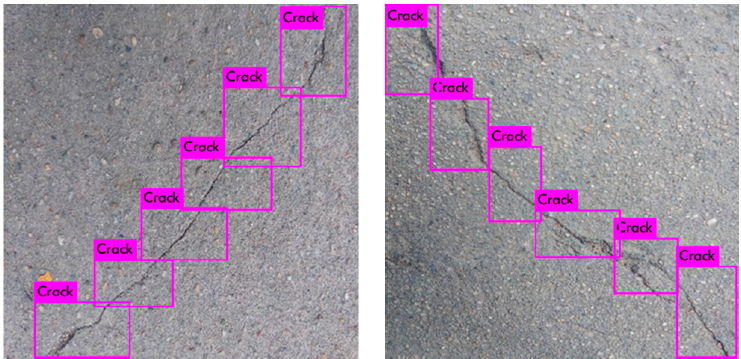
Figure 12. Image